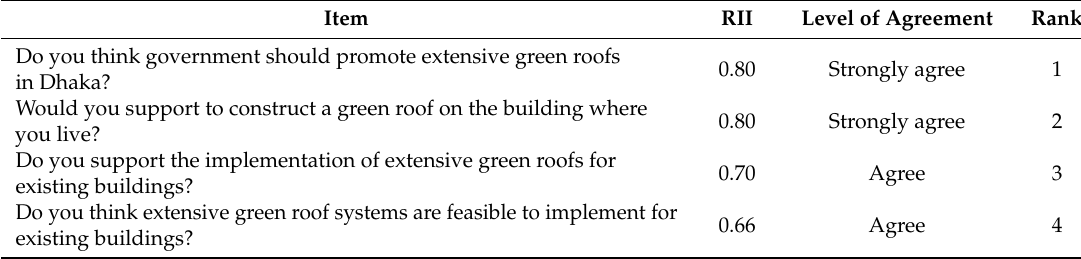
Table 7. Feasibility of extensive green roofs in